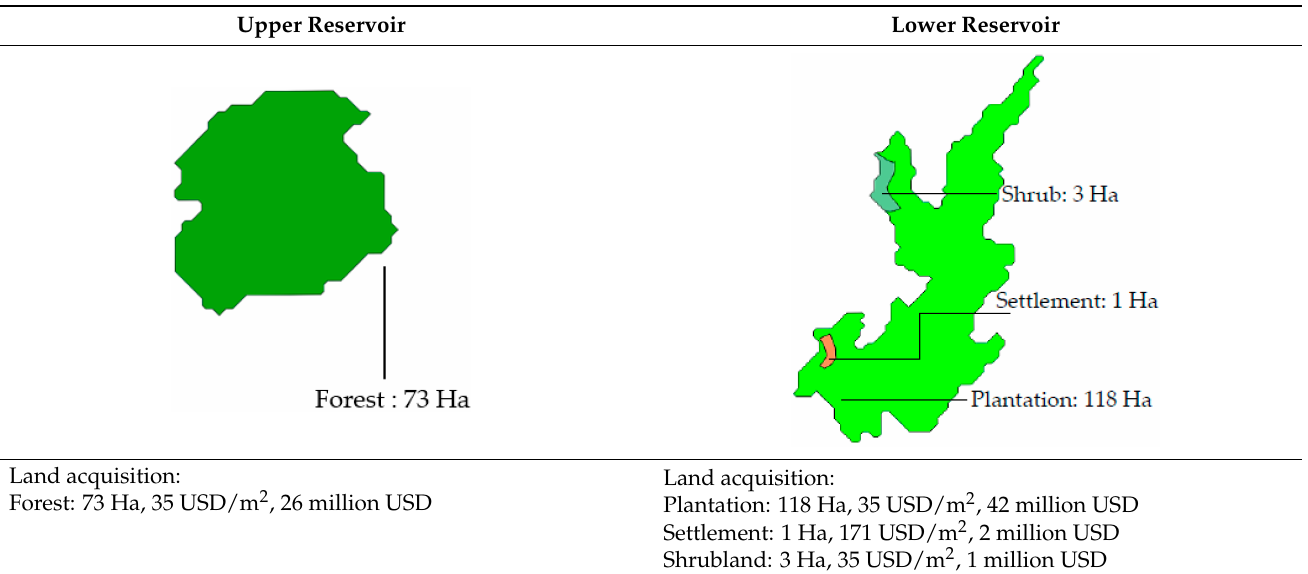
Table 4. Reservoir land categorisation and land acquisition cost estimation for an example PHES system in Jembrana Regency,